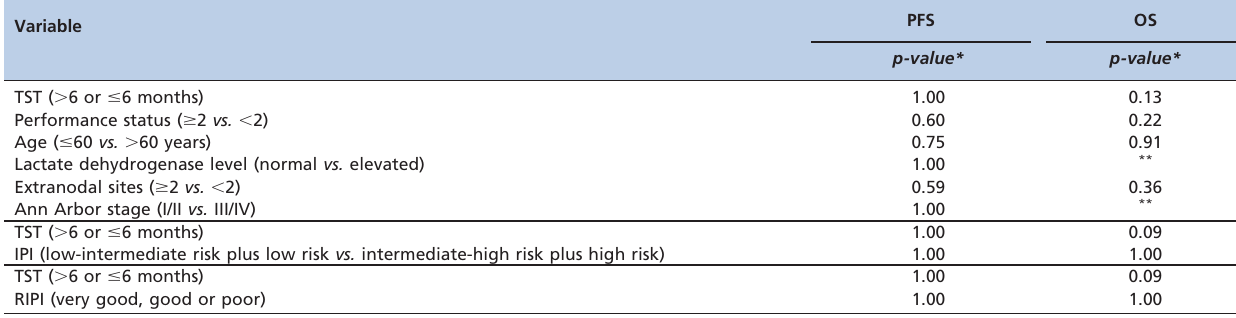
Table 3 - Multivariate analysis by Cox logistic regression.